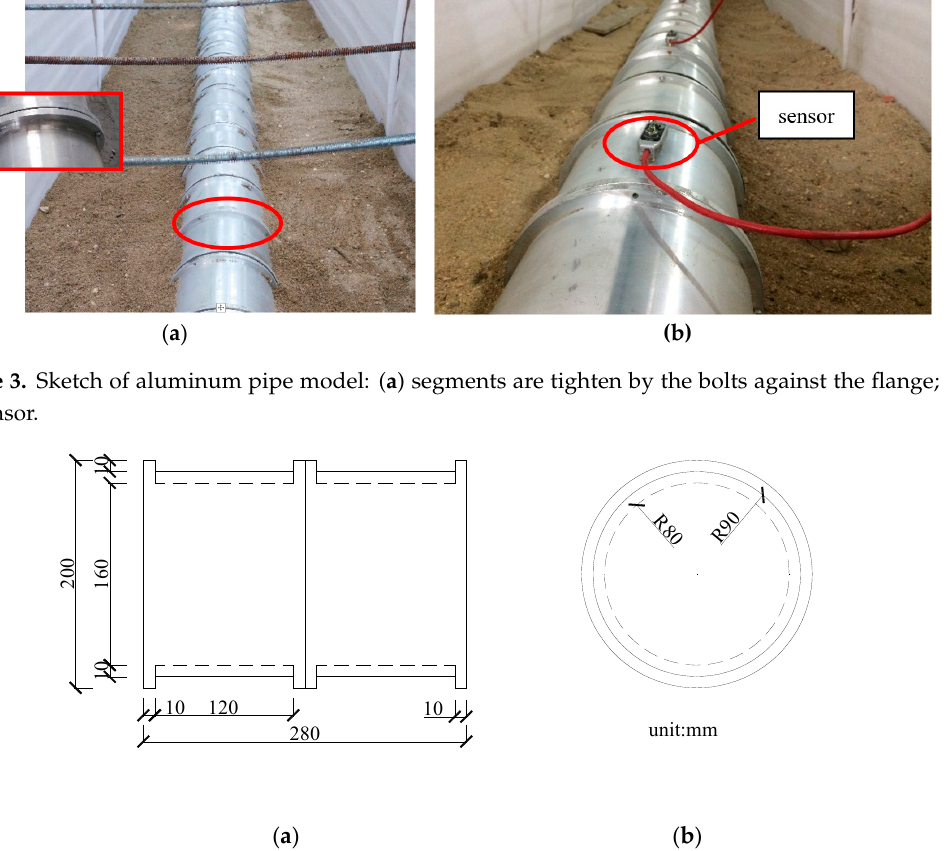
Figure 4. Shape and size information of aluminum segment model (unit: mm): ( a ) side view; ( b ) front view.